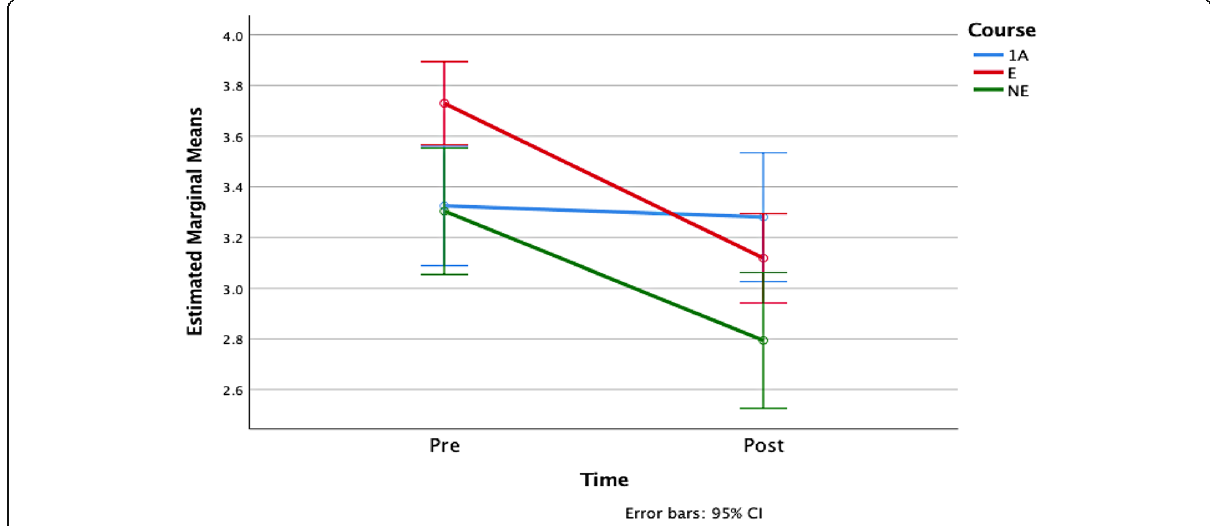
Fig. 1 Estimated marginal means of enjoyment